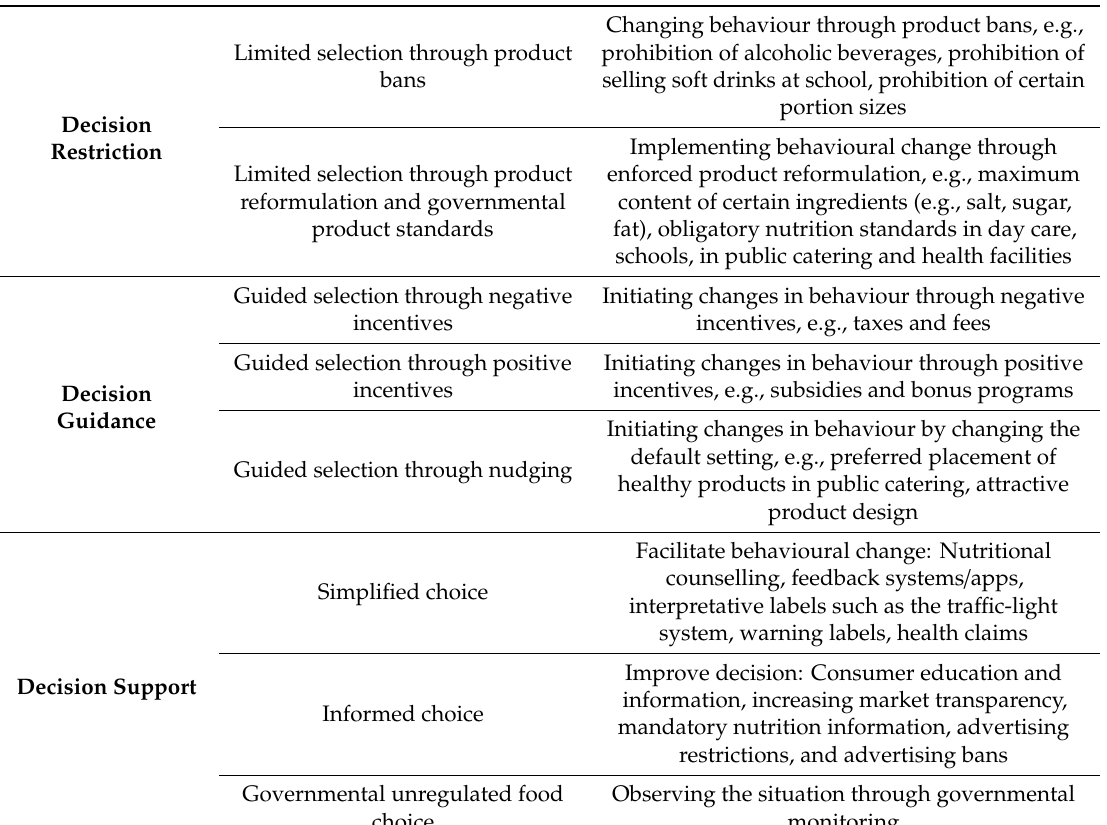
Table 1. Policy interventions for changing